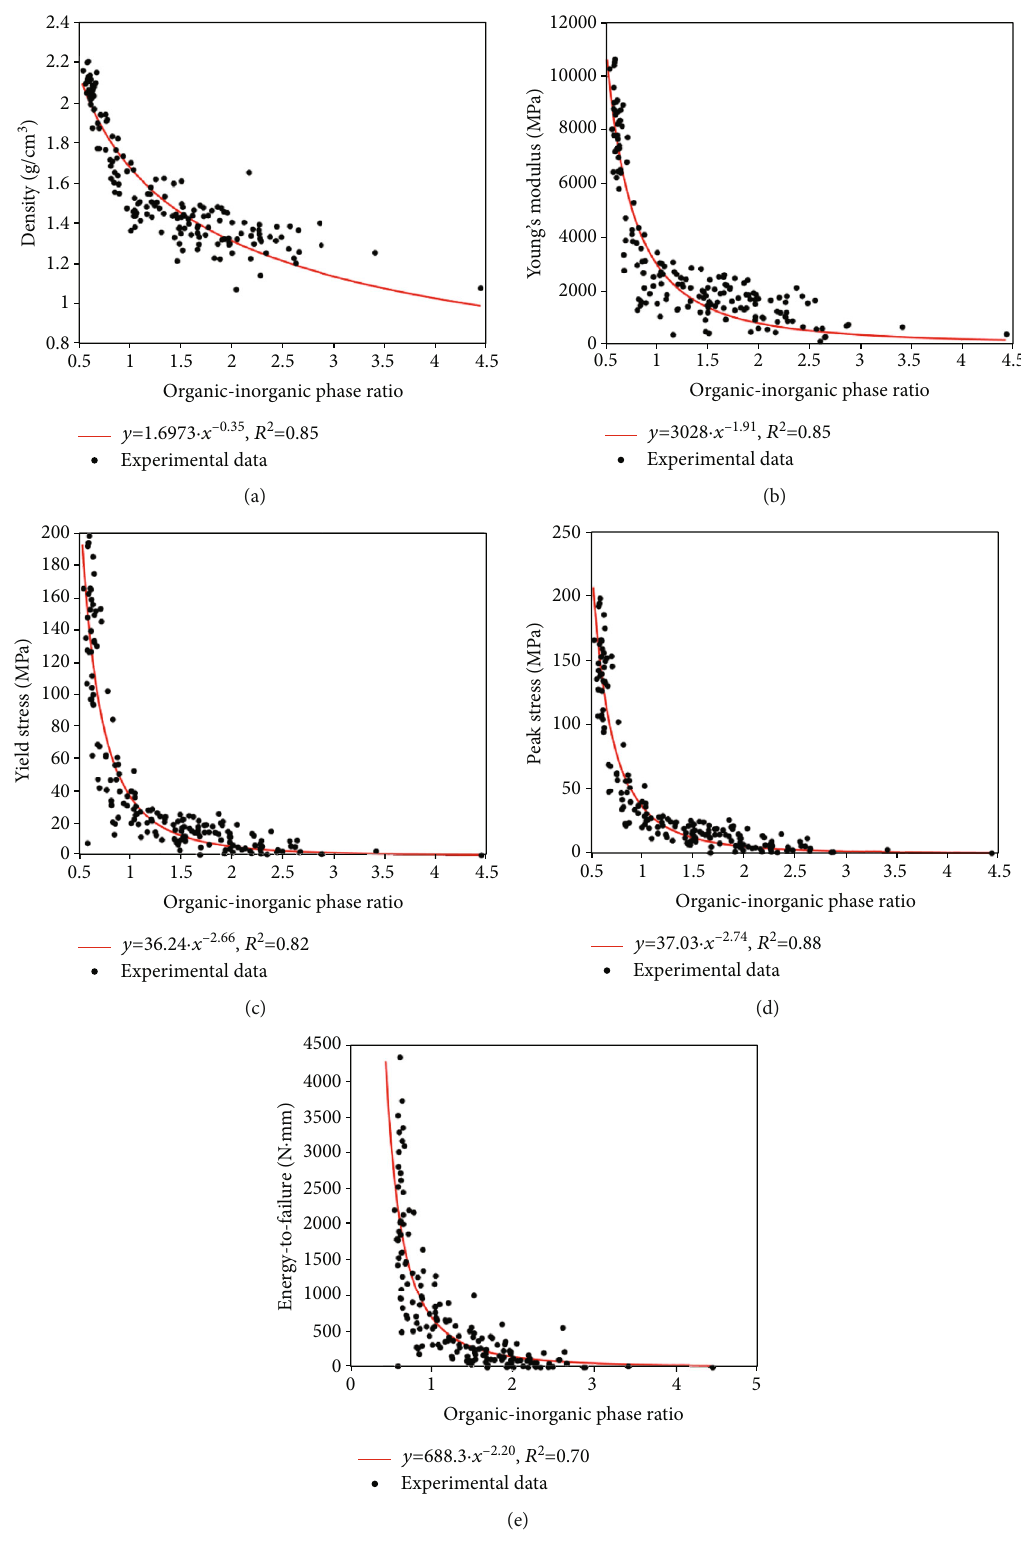
Figure 3: Variations of bone material properties with organic-inorganic phase ratio: (a) density; (b) Young ’ s modulus; (c) yield stress; (d) peak stress; (e)